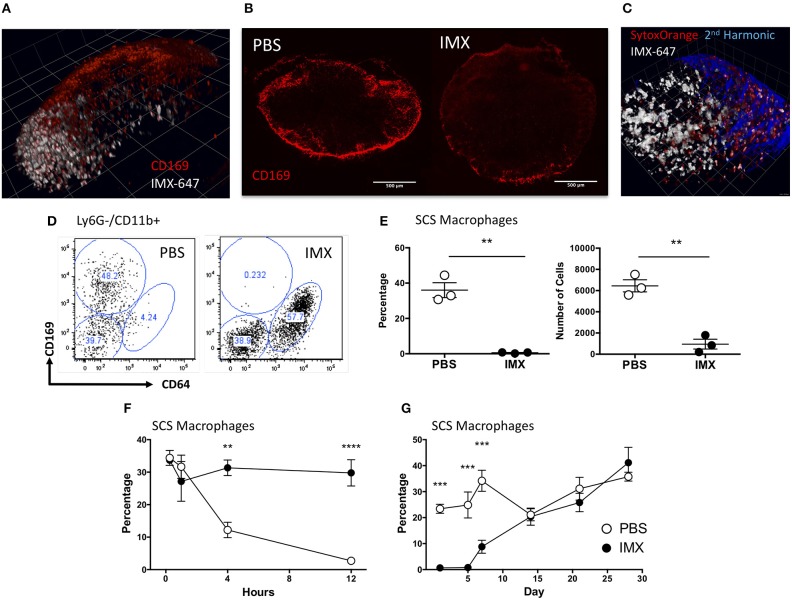
ISCOMATRIX localizes to the subcapsular sinus macrophages and these cells are lost from the lymph node following ISCOMATRIX treatment. (A) Mulitphoton image showing a popliteal lymph node labeled in vivo with a PE conjugated anti CD169 antibody and subsequently treated with 1 IU ISCOMATRIX-647 in the footpad. Imaging was performed 1 h after treatment with the ISCOMATRIX-647. (B) CD169 Immunohistochemical staining of cervical lymph nodes 24 h following immunization in the ear pinnae with either PBS or ISCOMATRIX. (C) Mulitphoton image showing the popliteal lymph node approximately 2 h following the co-administration of the cell impermeable DNA dye Sytox orange and ISCOMATRIX-647 in the footpad. (D) Representative plots showing CD169 and CD64 expression on Ly6G- CD11b+ cells in the draining lymph node from mice treated with PBS or ISCOMATRIX at 24 h. (E) Flow cytometry data showing the percentage and number of CD11b+ cells that are CD169+ SCS macrophages in the cervical lymph node at 24 h following immunization with PBS or ISCOMATRIX in the ear pinnae. (F) The percentage of CD11b+ cells that are CD169+ SCS macrophages in the cervical lymph node over the first 12 h following immunization with PBS or ISCOMATRIX in the ear pinnae. (G) The recovery of the of CD11b+ cells that are CD169 + SCS macrophages in the cervical lymph node over 28 days following immunization with PBS or ISCOMATRIX in the ear pinnae. Groups contained 3 animals. IMX, ISCOMATRIX™ adjuvant, **P < 0.01, ***P < 0.001 ***P < 0.0001.